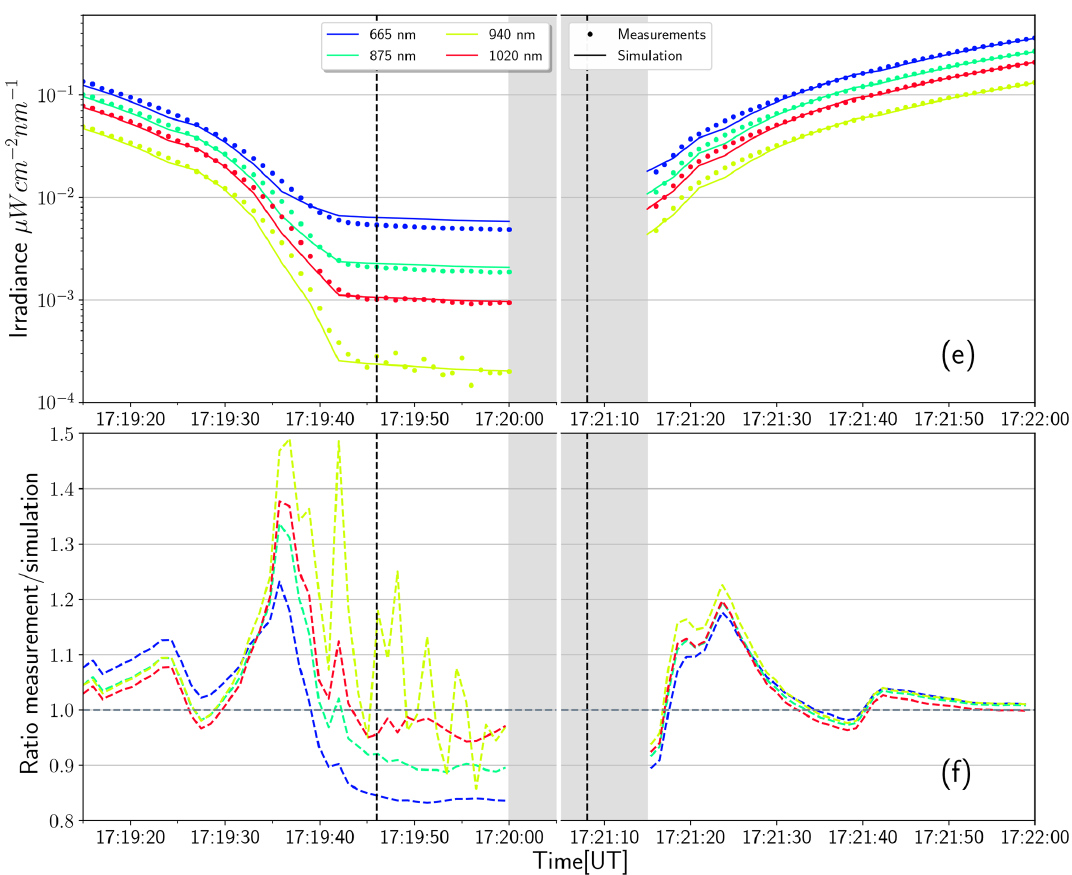
Figure 16. Comparison of simulation and measurements for wavelengths from 306 to 1020nm. Panel (a) shows simulated (solid line) and measured (dotted line) irradiance for wavelengths in the range from 300 to 400nm. Panel (b) shows the measurements divided by the simulation values (dashed line). The x axis is discontinuous and does not show the period between 17:20:05 and 17:21:05UTC because the shadow band swiped over the sensor between 17:20:00 and 17:21:10UTC (gray shading). The vertical, dashed lines show the theoretical start and end of totality. (c, d) Same as (a) and (b) , but for wavelengths from 400 to 600nm. (e, f) Same as (a) and (b) , but for wavelengths from 600 to